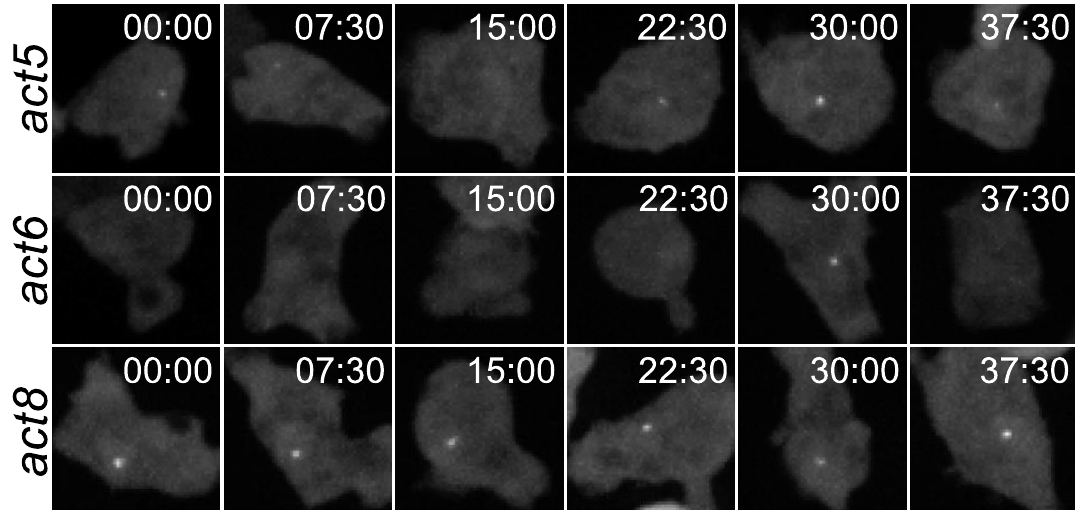
Figure 2. Imaging transcription in living cells. Images are stills from movies of Dictyostelium cells with different actin genes tagged using the MS2 RNA detection system. Nascent RNA appears at the site of transcription as a fluorescent spot. Different genes show different spot appearance and disappearance kinetics, with act5 and act6 genes being more “bursty” and act8 more constitutive. Image reproduced from [31]. Bursting transcription is now known to be conserved in all forms of life, from bacteria to mammalian cells, and has been implicated as a driver of cellular heterogeneity in diverse contexts- such as underlying HIV latency, the persistence of bacteria and cancer cells exposed to drug treatment, and cell fate separation during development.